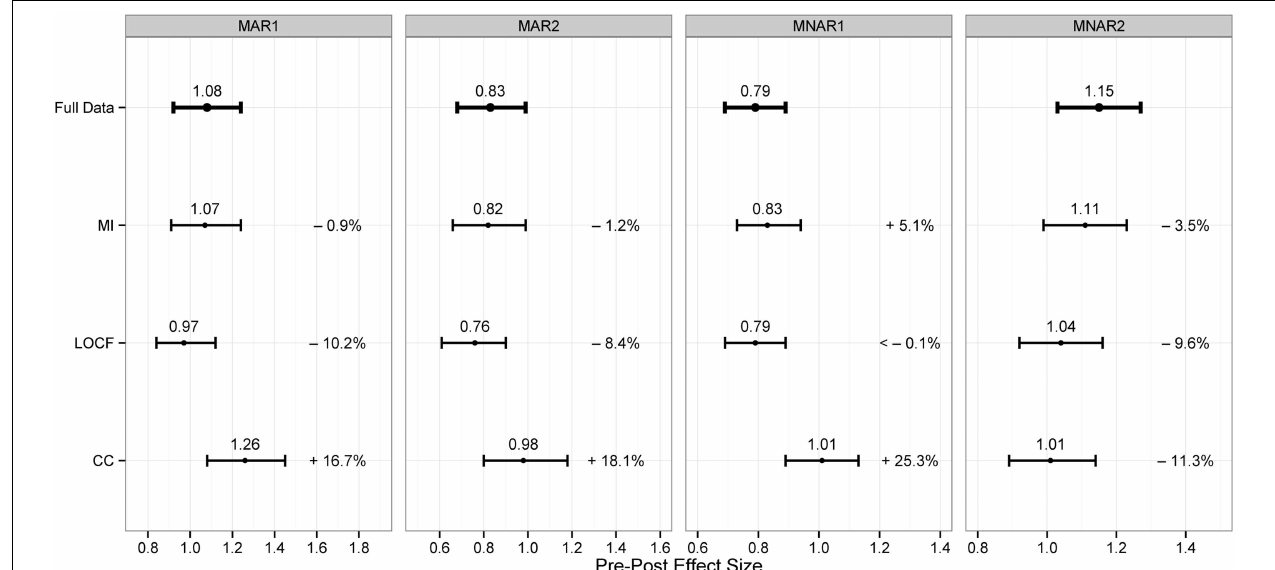
FIGURE 1 | Results of the simulations: Point estimates, CIs 95% and percentage biases.